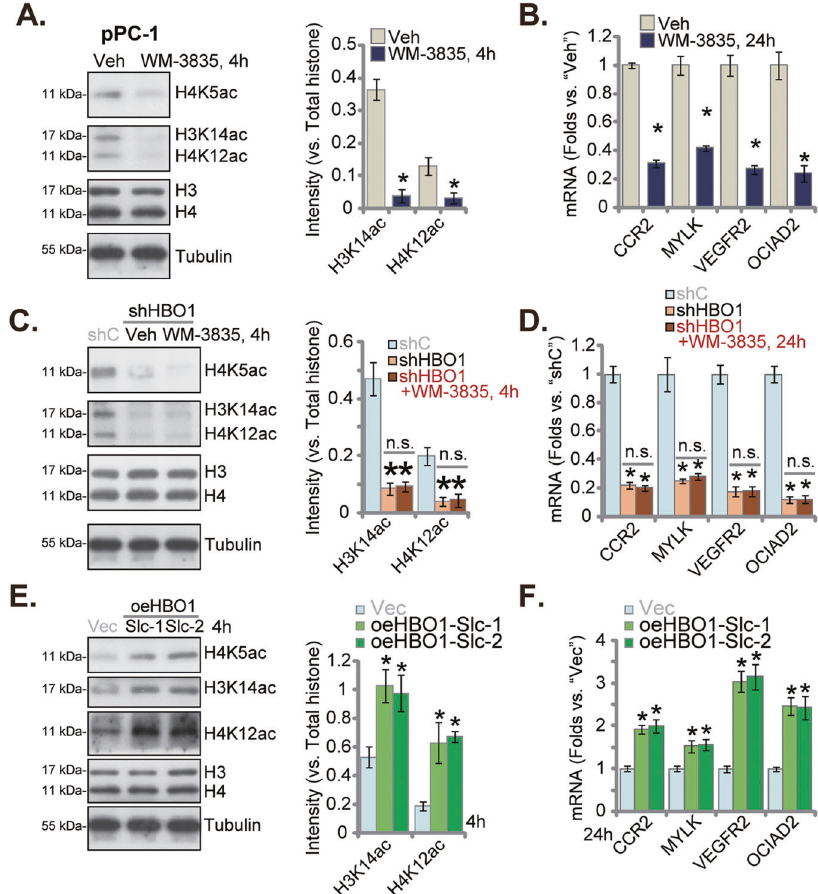
Fig. 5 WM-3835 inhibits H3-H4 acetylation and expression of several pro-cancerous genes in primary CRPC cells. The primary pPC-1 cells were treated with WM-3835 (10 μ M) or vehicle control ( “ Veh ” ) for designated hours, expression of listed proteins and mRNAs were tested ( A and B ). The stable primary pPC-1 cells with HBO1 shRNA ( “ shHBO1 ” ) or the scramble control shRNA ( “ shC ” ) were further treated with or without WM-3835 (10 μ M) for designated hours, expression of listed proteins and mRNAs were tested ( C and D ); The primary pPC-1 cells, with the lentiviral HBO1-expressing construct (oeHBO1-Slc-1 and oeHBO1-Slc-2, two stable selections) or the empty vector ( “ Vec ” ) were established, expression of listed proteins and mRNAs were tested ( E and F ); Data were expressed as the mean ± standard deviation (SD, n = 5). * P < 0.05 versus “ Veh ” / “ shC ” / “ Vec ” group. “ n. s. ” stands for non-statistical difference ( P > (Fig. 7H). Thus, WM-3835 administration provoked apoptosis activation in pPC-1 xenografts. HBO1 silencing hinders pPC-1 xenograft growth in nude mice To further support the important role of HBO1 on CRPC cell growth, the pPC-1 xenograft-bearing mice were treated with AAV- packed HBO1 shRNA ( “ aav-shHBO1 ” ) or AAV-packed scramble control shRNA ( “ aav-shC ” ). AAV was intratumorally injected, daily for 10 days. Tumor volumes were again recorded. Results revealed that aav-shHBO1 injection potently inhibited pPC-1 xenograft